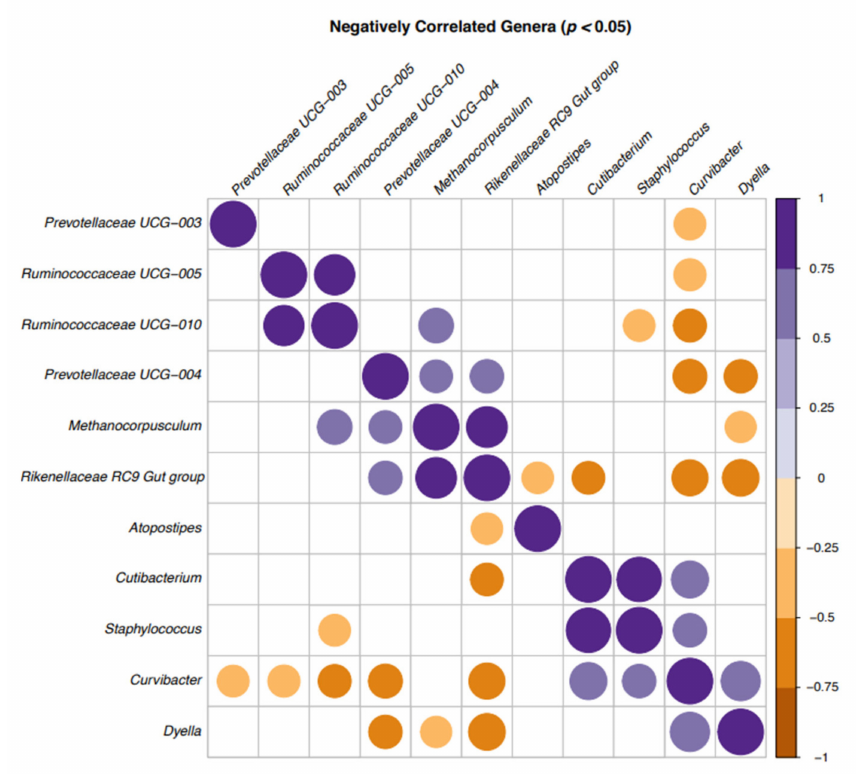
Figure 2. Correlation plot of the bacteria in bull semen identified by 16S sequencing in a correlation matrix showing the significant correlations ( p < 0.05) between genera: positive (purple) and negative (brown). Blank cells indicate non-significant correlations.